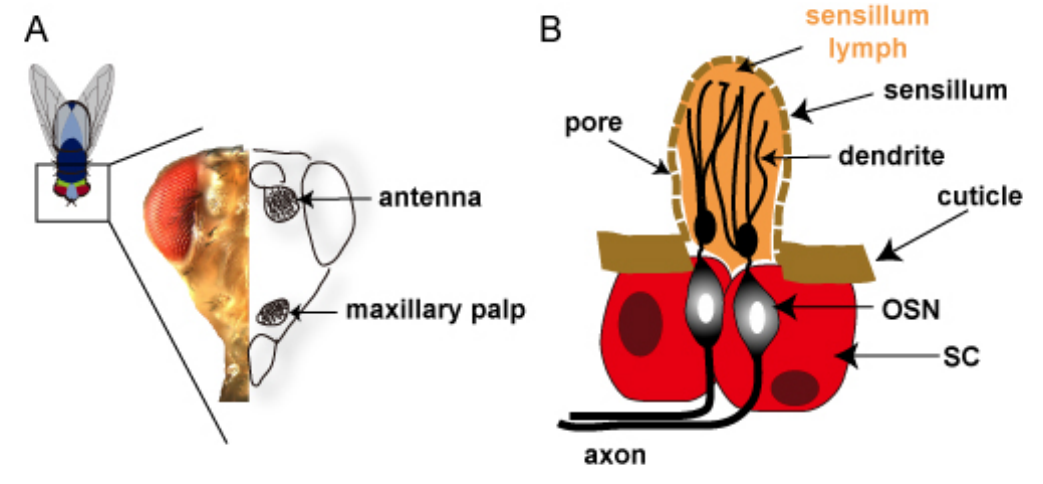
Figure 5. Anatomy of the insect olfactory